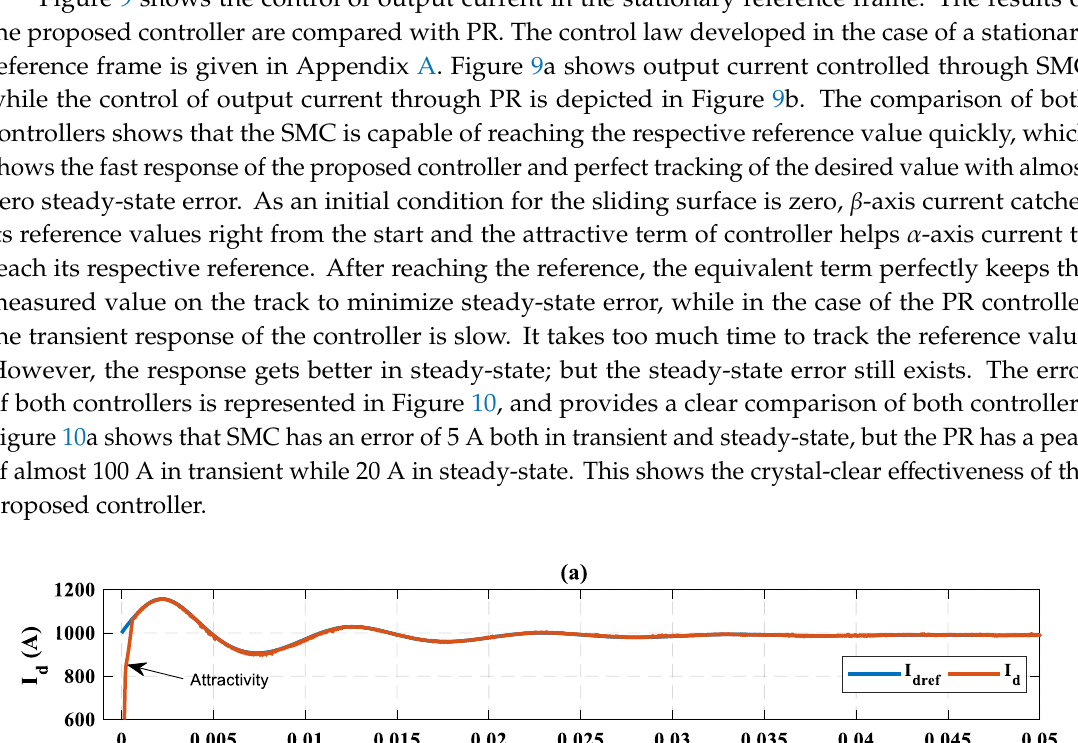
Figure 9. Output c urrent in αβ -axis and its references; ( a ) control using sliding mode control (SMC); ( b ) control using proportional resonant (PR) . Figure 10. Error signal of output current; ( a ) SMC; ( b ) PR.